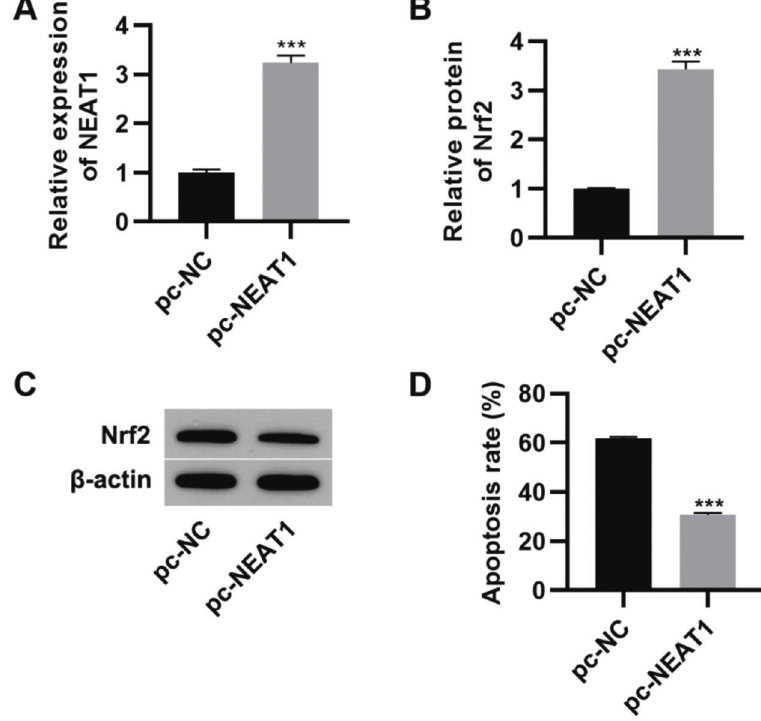
Figure 3 - Upregulation of NEAT1 inhibited the apoptosis of myocardial cells. Transfection of pcDNA3.1- NEAT1 upregulated the mRNA expression of NEAT1 (A) and Nrf2 protein levels (B-C) and inhibited apoptosis (D) in H9c2 cells maintained in high-glucose (HG) medium. *** p o 0.001, Mann-Whitney U